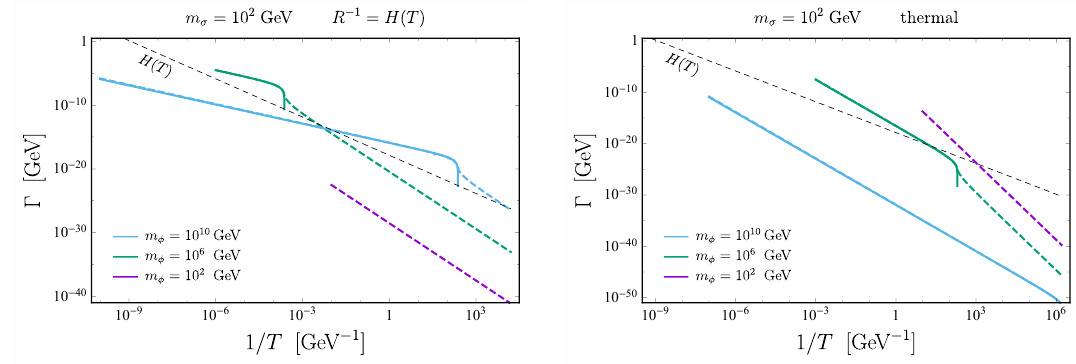
Figure 7 . The temperature dependence of the zero mode decay width with E = m φ and m σ = 10 2 GeV . The colored solid and dashed lines correspond to the conversion Γ and the two-body conv decay Γ , respectively. (Some dashed and solid lines are overlapped.) The dashed black lines 2 -body denote the Hubble parameter H ( T ) . (Left) The dependence comes from R = H − 1 (the scaling regime). The Yukawa coupling is set to λ = 1 . (Right) The thermal curve with which the analysis is assumed to be valid at T < 10 − 3 m φ